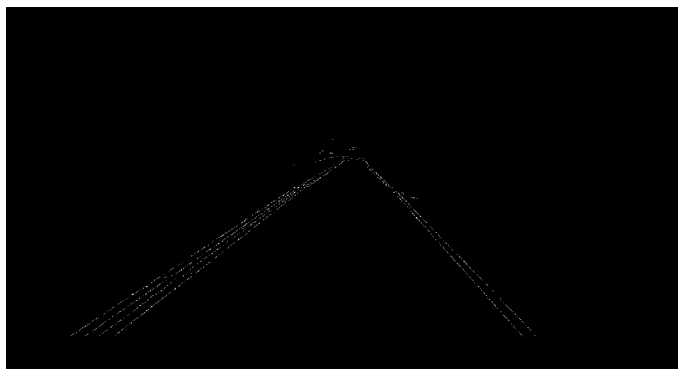
Figure 16. Removing edge pixels using the probabilistic Hough transform method.